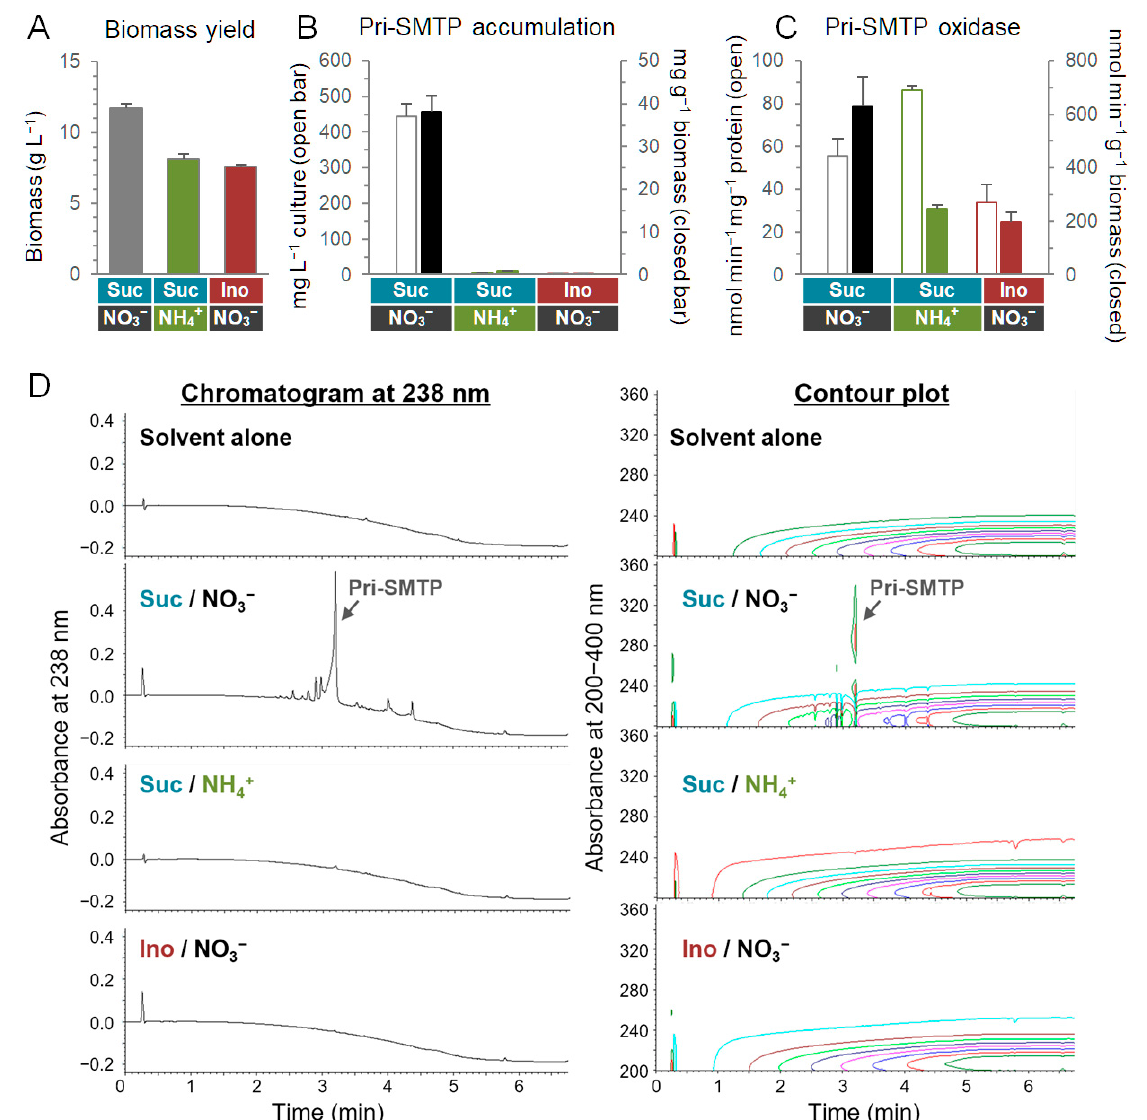
Figure 6. Nutrient regulation of the biosynthesis of pri-SMTP. Biomass yield ( A ), pri-SMTP accu- mulation ( B ), and pri-SMTP oxidase activity ( C ) in S. microspora grown on different nutrients. The standard medium (Suc/NO 3 − ) consisted of sucrose (5%, wt vol − 1 ) and KNO 3 (70 mM) as the major carbon and nitrogen sources, respectively. Suc/NH 4+ medium contained 70 mM NH 4 Cl in place of KNO 3 , and sucrose was replaced by myo -inositol (5%, wt vol − 1 ) in Ino/KNO 3 medium. Pri-SMTP oxidase activity was obtained by measuring the consumption of pri-SMTP. Each value represents the mean + SD (error bar) from triplicate cultures. ( D ) Chromatogram at 238 nm and contour plot of the UPLC analysis of the MeCN extract from S. microspora grown on different nutrients. The solvent system shown in Section 2.4 was used. The contour plots suggested that there was a little amount of metabolites (including those other than pri-SMTP) in the Suc/NH 4+ and Ino/KNO 3 cultures. Pri-SMTP localization was visualized using fluorescence microscopy (Figure